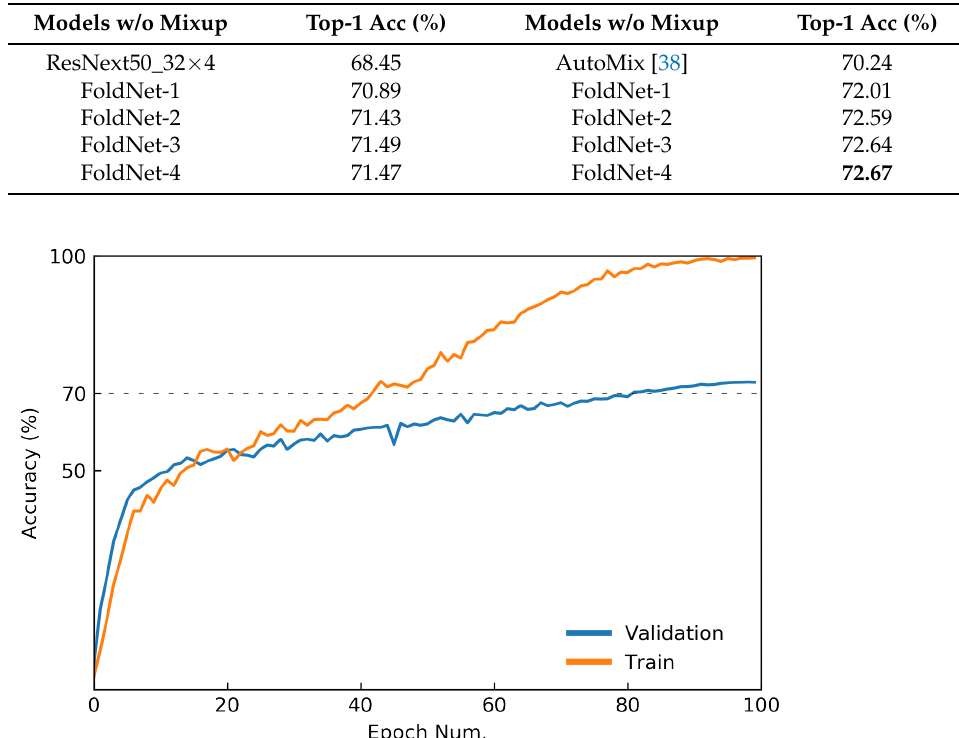
Figure 10. Accuracy curves of FoldNet-4 with Mixup on the Tiny ImageNet dataset when hidden dimension h = 640 and network depth n =